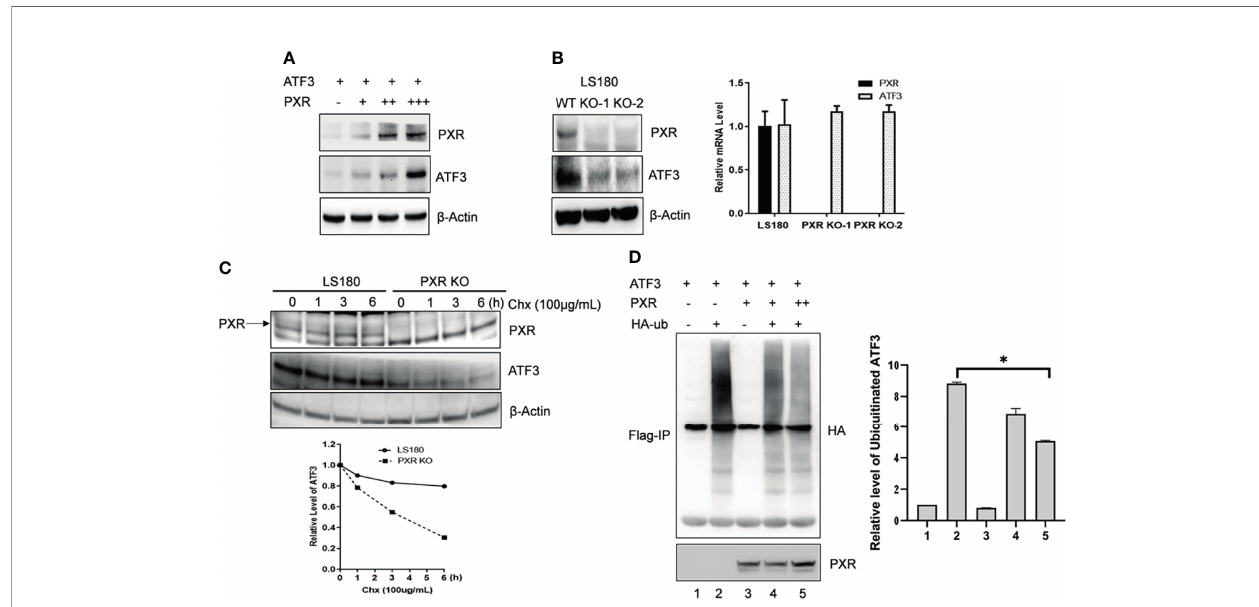
FIGURE 2 | PXR increased ATF3 stability by blocking its ubiquitination. (A) Co-transfection of PXR increased the ATF3 protein levels. H1299 cells were transfected with 0.2 m g FLAGATF3 and 0, 0.4, 0.8, or 3.2 m g PXR plasmids as indicated for 2 days. The protein levels were determined using Western blotting. (B) PXR regulates ATF3 in protein level. Two LS180 PXR KO clones (KO-1 and KO-2) and the wild-type cells were subjected for Western blotting and quantitative RT-PCR. (C) PXR stabilizes ATF3 protein. LS180 wild-type or PXR KO cells were treated with 100 m g/ml of cycloheximide (Chx), and lysed for Western blotting as indicated. Relative ATF3 levels were quantitated by densitometry and presented in the lower plot. (D) PXR decreased the ATF3 ubiquitination level. Lysates from H1299 cells transfected with 1 m g FLAG-ATF3, 2 m g HA-ubiquitin, and/or PXR plasmids (lane 3 and lane 4, 2 m g; lane 5, 4ug) were subjected to immunoprecipitation assays using the FLAG agarose beads (Sigma) followed by SDS-PAGE. Ubiquitinated ATF3 were detected by HA antibody. *p <